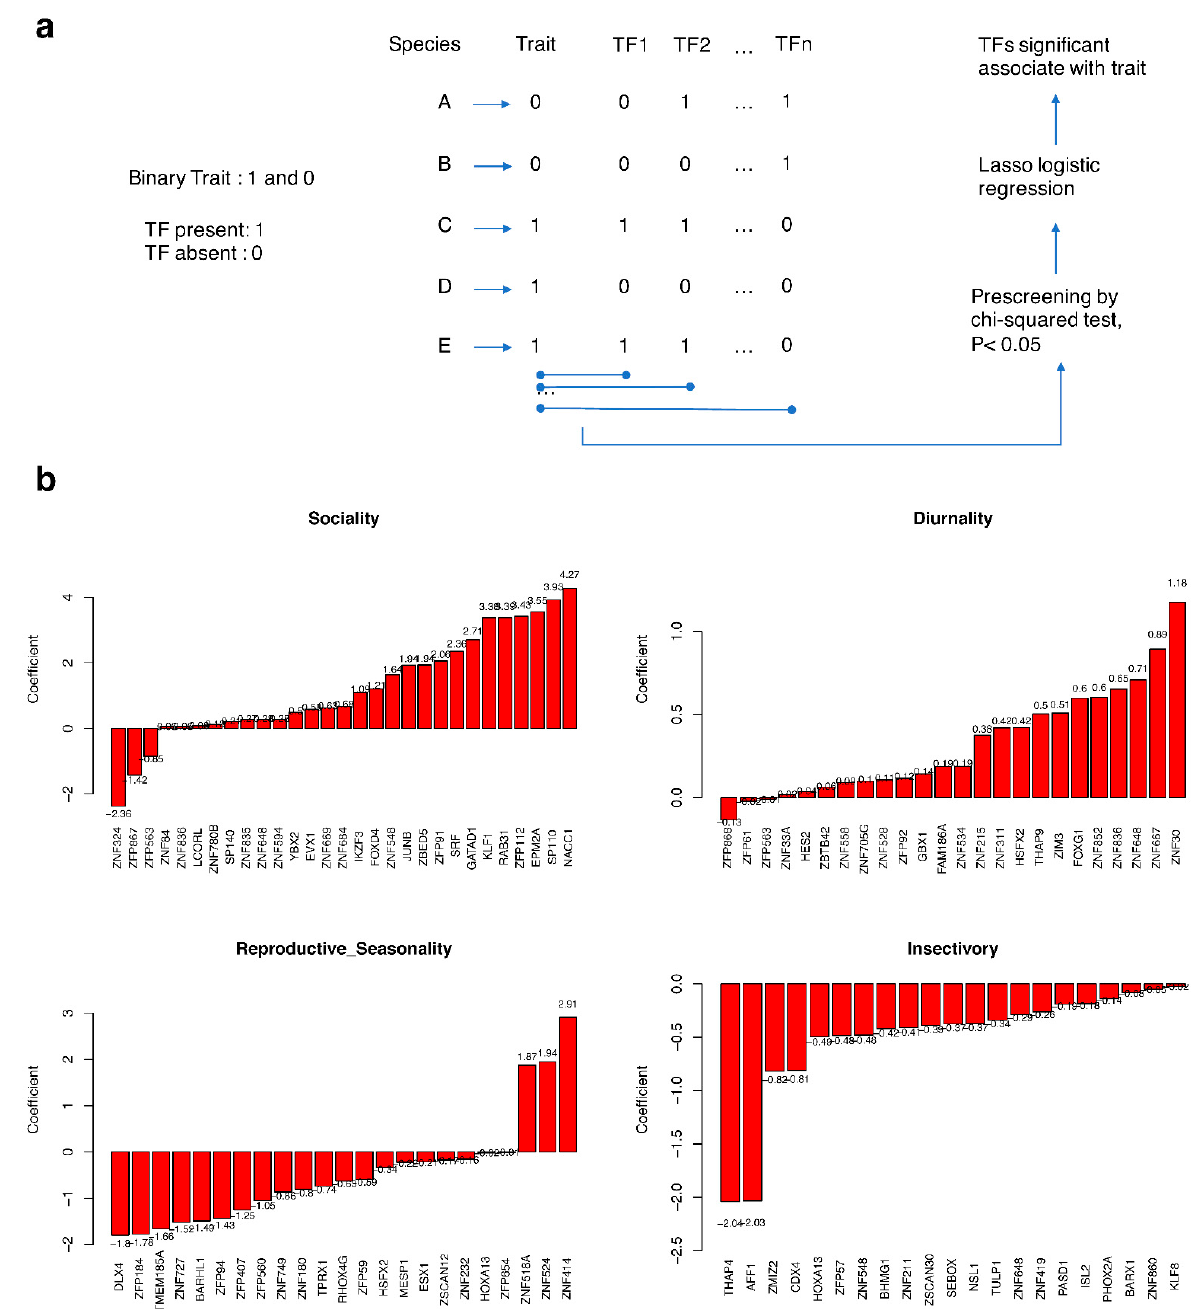
Figure 4. Association of TF loss with mammalian traits. ( a ) The pipeline used to detect an association between TF presence/absence and life history traits by lasso logistic regression. ( b ) TFs significantly associated with traits. The x -axis shows TF genes significantly related to the indicated trait, and y -axis values are lasso logistic regression coefficients pre-screened with a chi-square test ( P < 0.05).